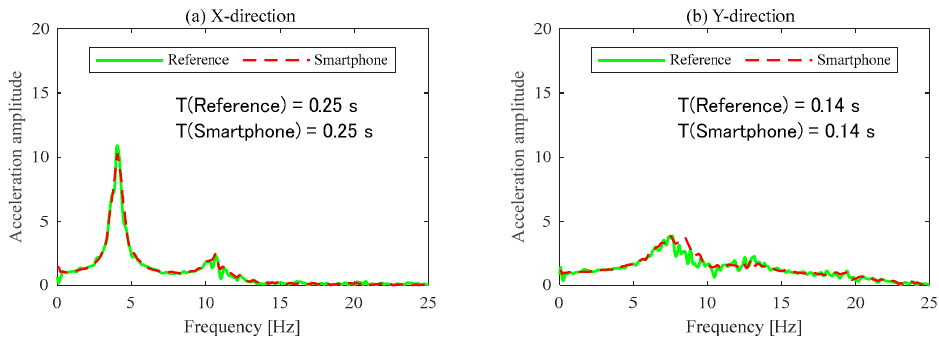
Figure 4. Estimated natural period.